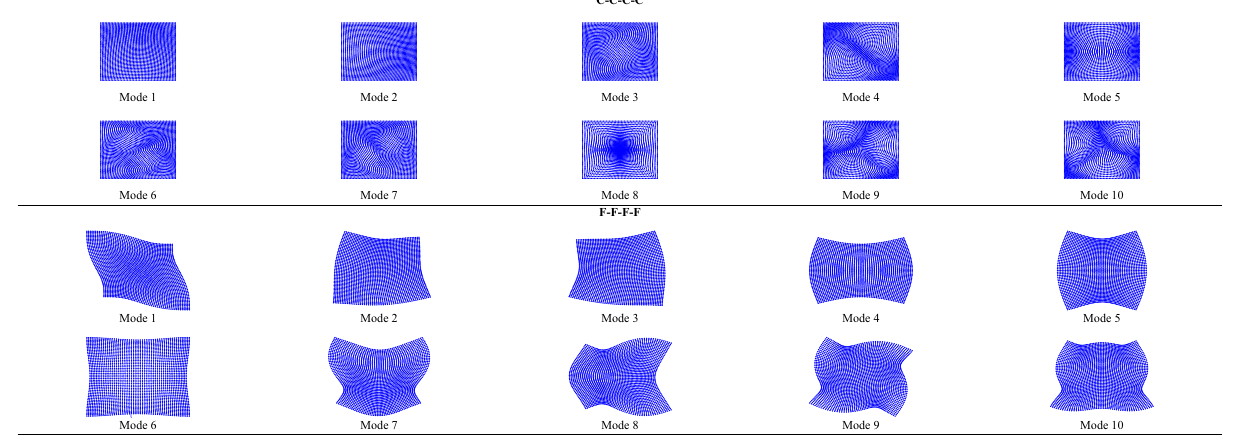
Figure 3. The first ten vibration modes of isotropic square plates with ν = 0.3 .